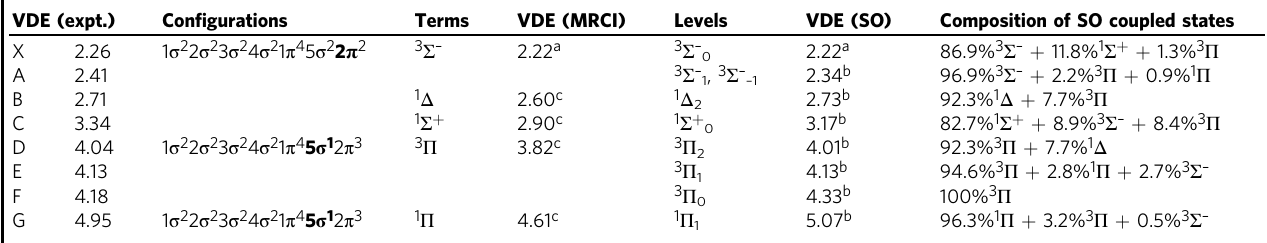
The observed features and their vertical detachment energies (VDEs) from the photoelectron spectra of PbB2O – in comparison with theoretical values. All energies are given in eV. a The fi rst VDE was calculated at the CCSD(T) level. b The higher VDEs were calculated with the SO coupling effect considered. c The higher VDEs were calculated using the MRCI approach.